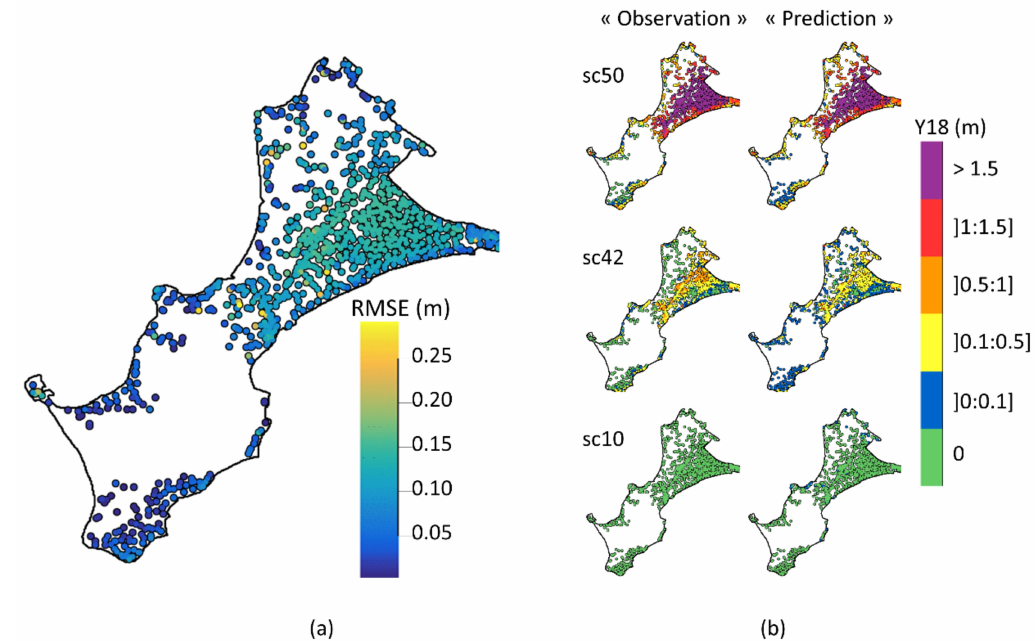
Figure 11. Cross-validation of the Y 18 metamodel. ( a ) RMSE over the 174 scenarios of the learning dataset computed by LOO cross-validation. ( b ) Y 18 “predictions” obtained with the metamodel for three of the 174 scenarios by LOO cross-validation compared with the “observations” Y num obtained directly from the numerical model outputs. The colour scale in panel ( b ) corresponds to the colour scale of indicator I 14